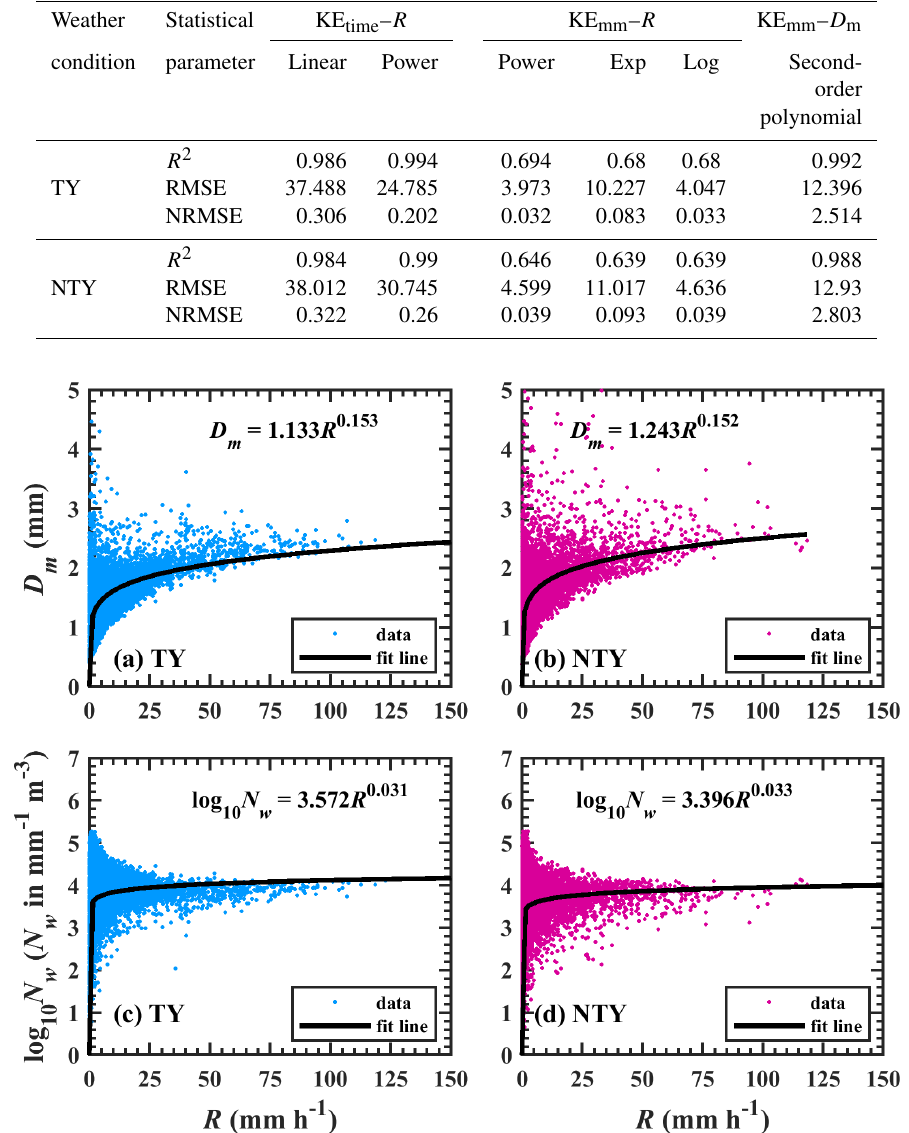
Figure 10. Distributions of D m (mm) and log 10 N w ( N w in mm − 1 m − 3 ) with the rainfall rate ( R ; mmh − 1 ) for typhoon (TY) and non- typhoon (NTY)